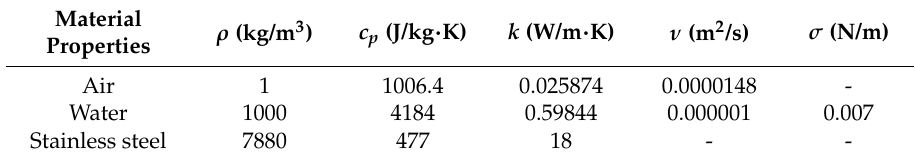
Table 3. Thermo-physical properties of the fluids and solid used in the performed simulations.